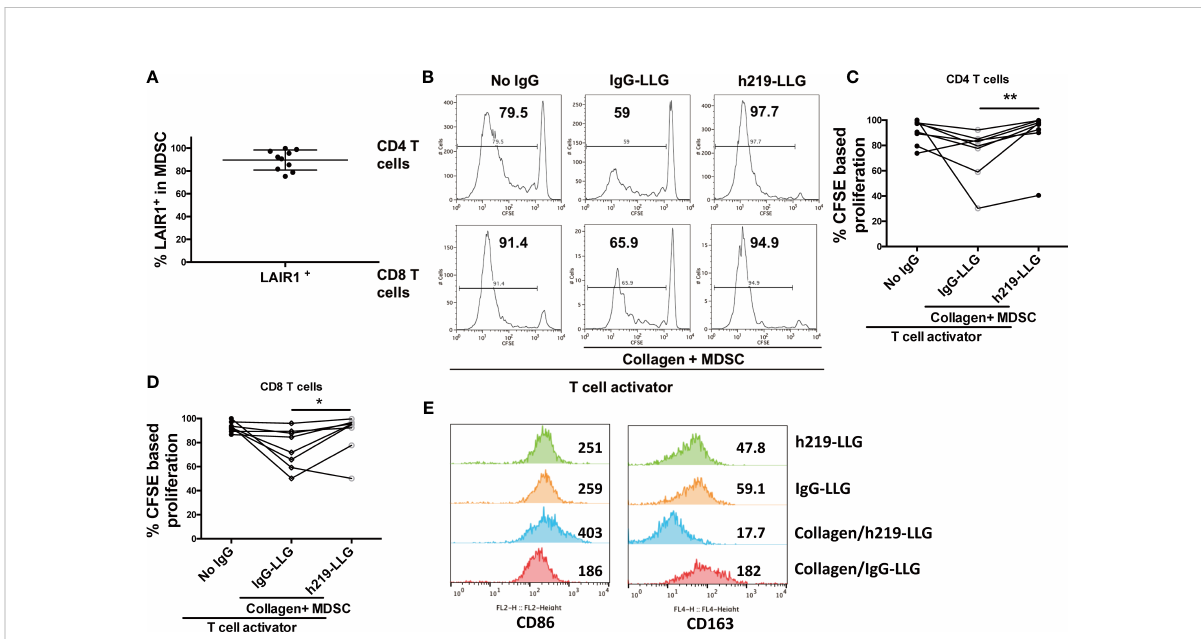
FIGURE 5 LAIR1 blockade inhibits MDSC activity and reactivates T cells in cancer patients. (A) LAIR1 + % in CD11b + HLA-DR dim cells as enriched MDSCs isolated from prostate cancer patients as determined by fl ow cytometry. (B) Representative histograms show that h219-LLG attenuated the T cell suppressive function of MDSCs from prostate cancer patients in a CSFE assay. The CD11b + HLA-DR dim cells were cocultured with CFSE- stained autologous T cells (E:T =1) for 5 days, treated with 10 µg/mL control or h219-LLG antibodies. (C, D) Quanti fi cation of the percentages of proliferative CD4 + and CD8 + T cells treated as indicated. (E) Enriched MDSCs from a patient with squamous cell carcinoma were cultured without T cells in the presence or absence of collagen, treated with h219-LLG or control antibodies for 5 days. Shown are MFIs of surface CD86 and CD163 as measured by fl ow cytometry. As Statistical Analysis in Methods stated: * indicates p < 0.05; ** indicates p <